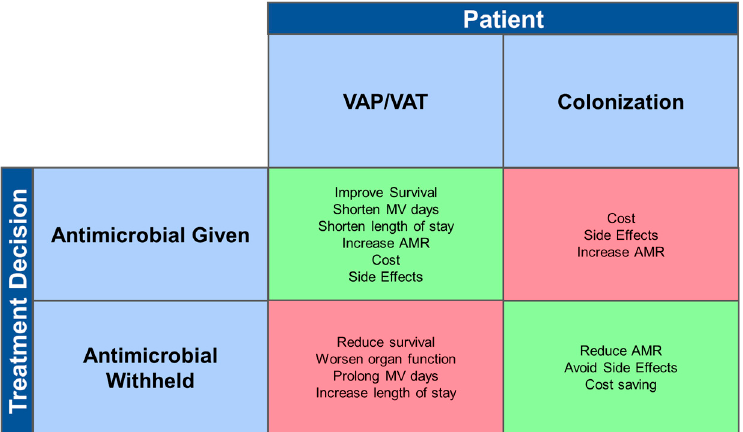
Figure 1. Risk and benefits of giving and withholding treatment for patients with VAP/VAT or respiratory colonization with MDRO. Red boxes represent consequences when decision to treat or not to treat is incorrect. Green boxes represent best case scenarios even when MDRO is isolated from respiratory samples of ventilated patients. AMR, antimicrobial resistance; MV, mechanical ventilation; VAP, ventilator-associated pneumonia; VAT, ventilator-associated